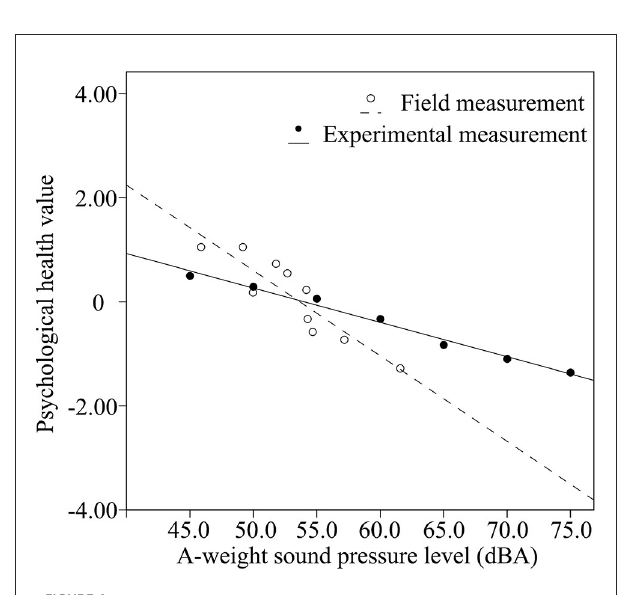
FIGURE4 Relationship between L Aeq and psychological health values within the cognitive